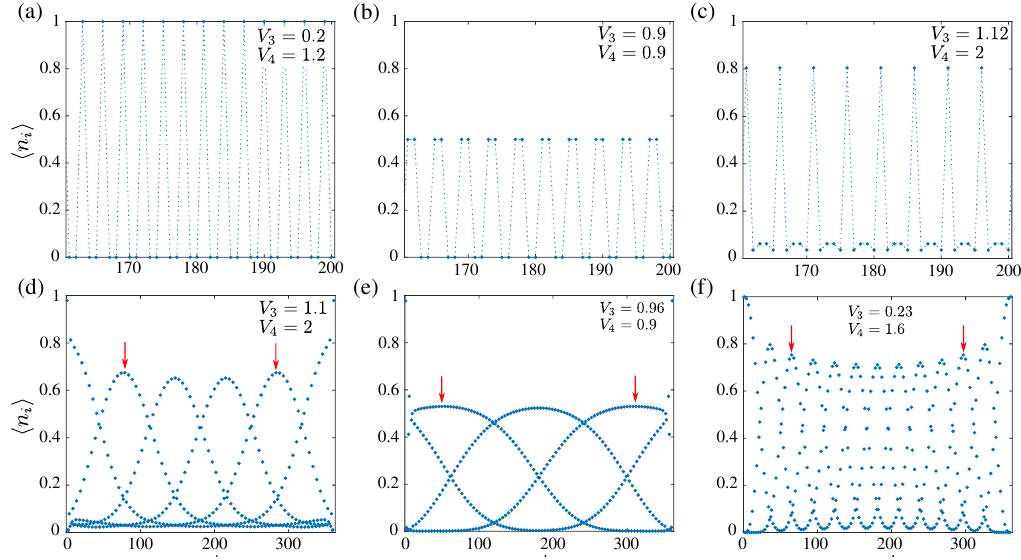
Figure 3: Local density profiles inside (a) period-3, (b) period-4, (c) period-5, and (d)-(f) floating phases. All presented profiles are computed for N = 361. For clarity, panels (a)-(c) show only the central part of the profile. In (d)-(f) the average density has been calculated between the peaks marked by the red arrows.